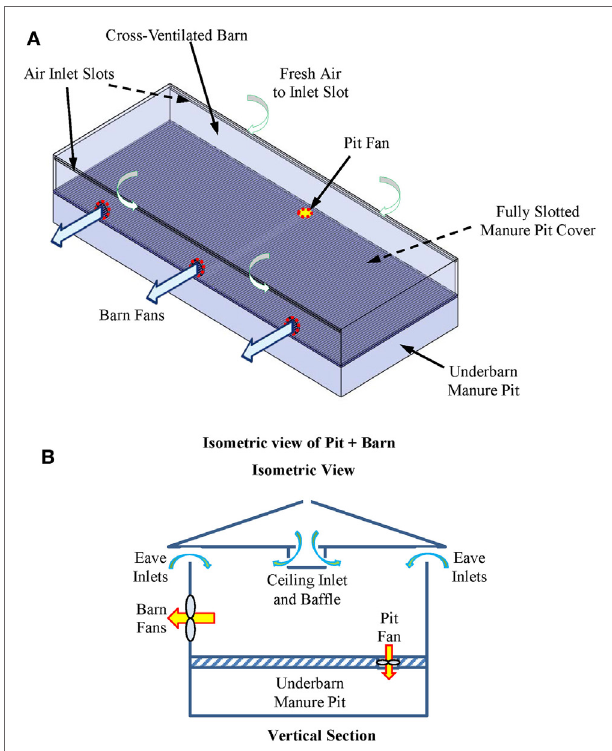
FIgURe 3 | Definition sketch of a slotted-covered manure pit beneath a cross-ventilated barn . (A) Isometric view and (B) vertical section showing general airflow direction in